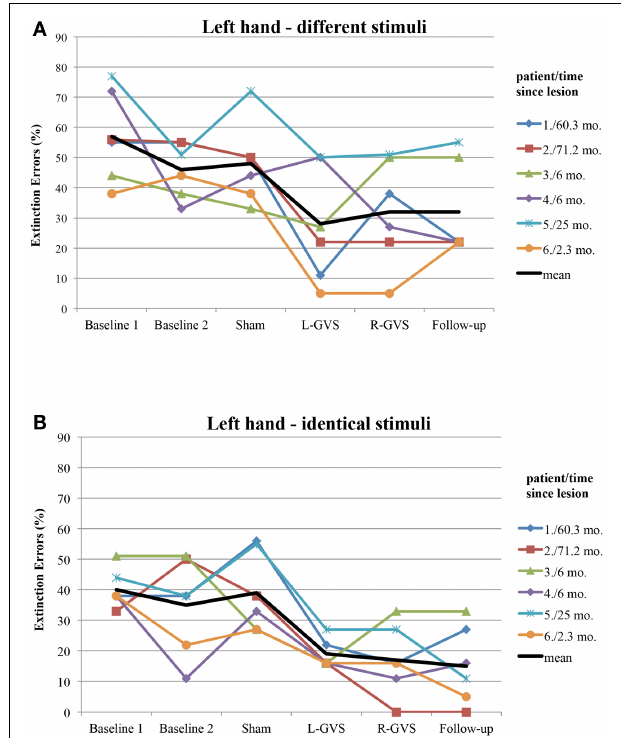
FIGURE 4 | Individual extinction errors (in degrees, averaged over 18 trials) of the six patients with left-sided extinction (GVS group) in the Quality ExtinctionTest (QET) across the different experimental conditions for the left arm and in relation to lesion chronicity (months), separately for application of different tactile stimuli (A) and of identical tactile stimuli (B). Abbreviations: see legend of Figure 2 . Mo, months. For patient codes and lesion chronicity, see Table 1